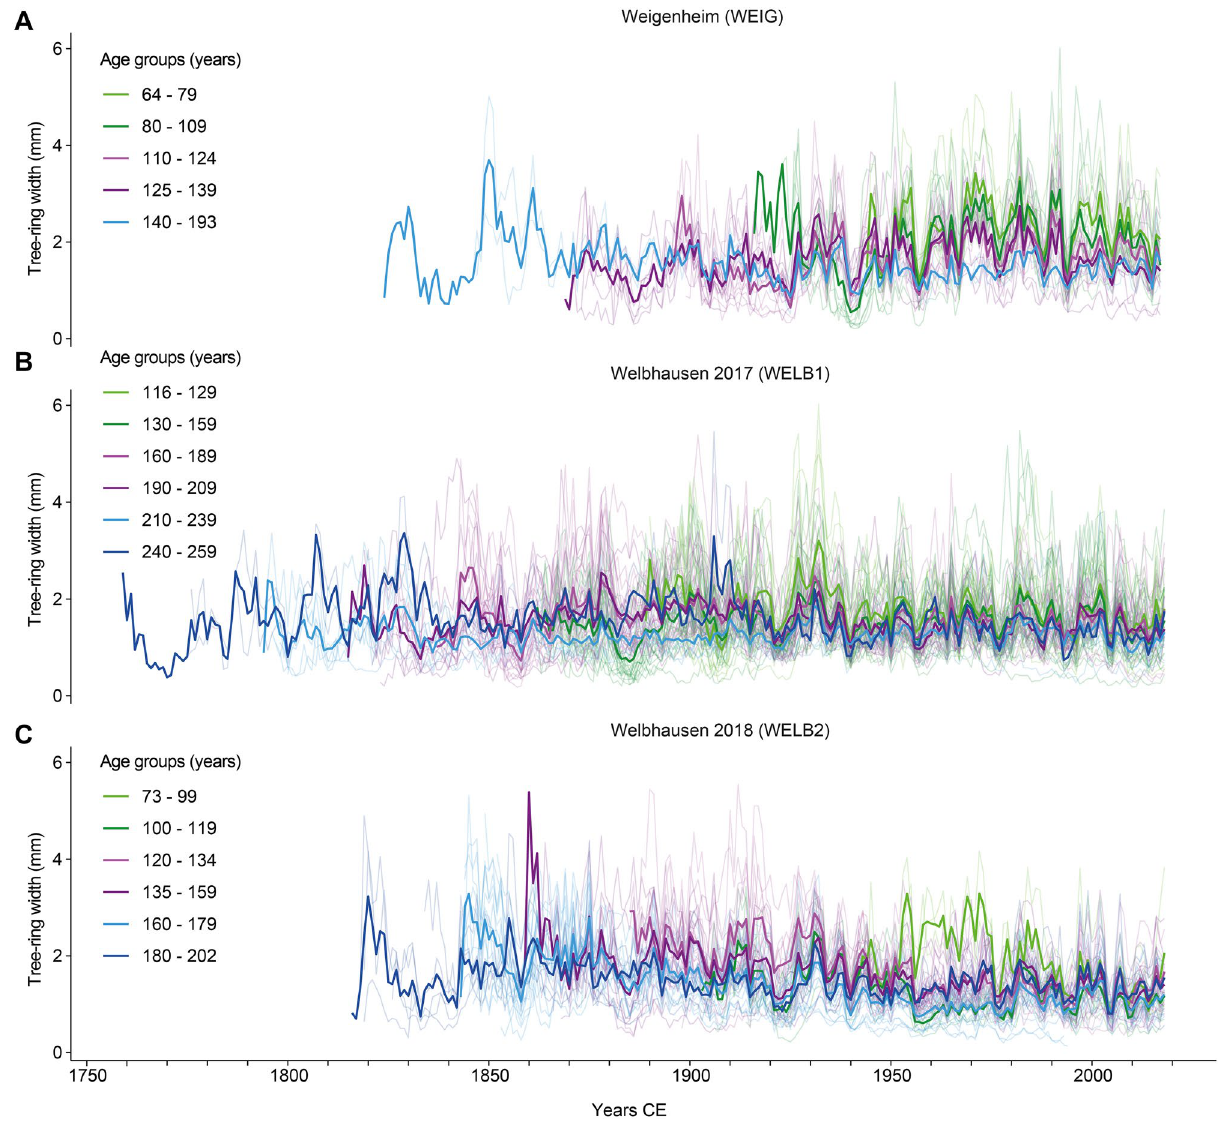
Figure 2. Tree-ring width curves (TRW) from Weigenheim ( A ) and Welbhausen ( B , C ) distributed in evenly replicated age groups. Young trees are shown in bright and dark green, middle-aged trees in bright and dark purple and old trees in bright and dark blue. Group means are represented by bold lines, single TRW are displayed in the background (thin semi-transparent lines). This figure was created using R software (https :// www.r-proje